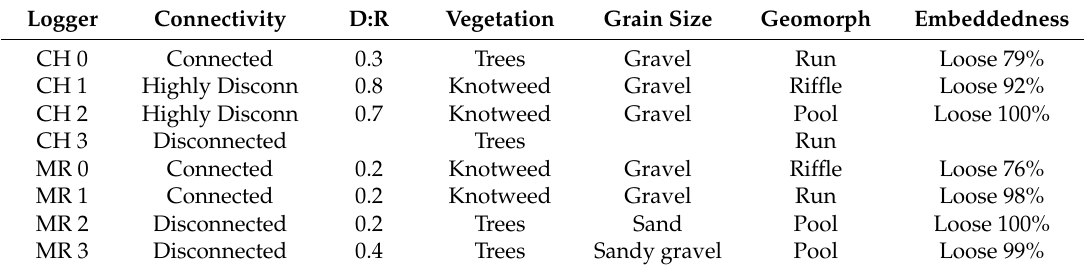
Table 2. Site characteristics for turbidity logger locations. Loggers in bold showed statistically different response from some of its